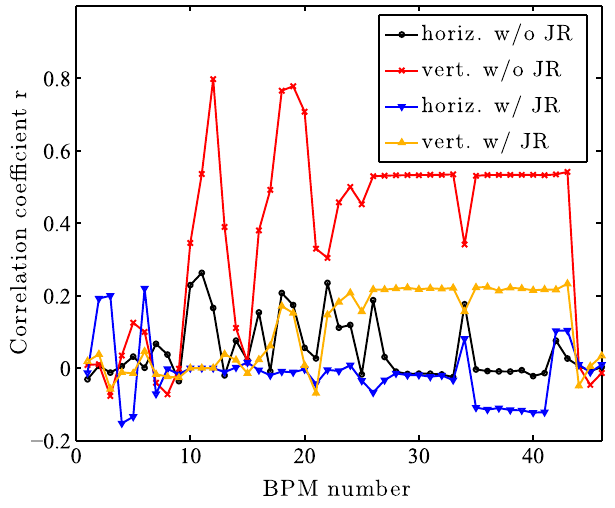
FIG. 12. Correlation coefficient calculated from the BPM measurements and the predictions from the ground motion sensors. The results are shown with and without removing the incoming orbit jitter (JR).